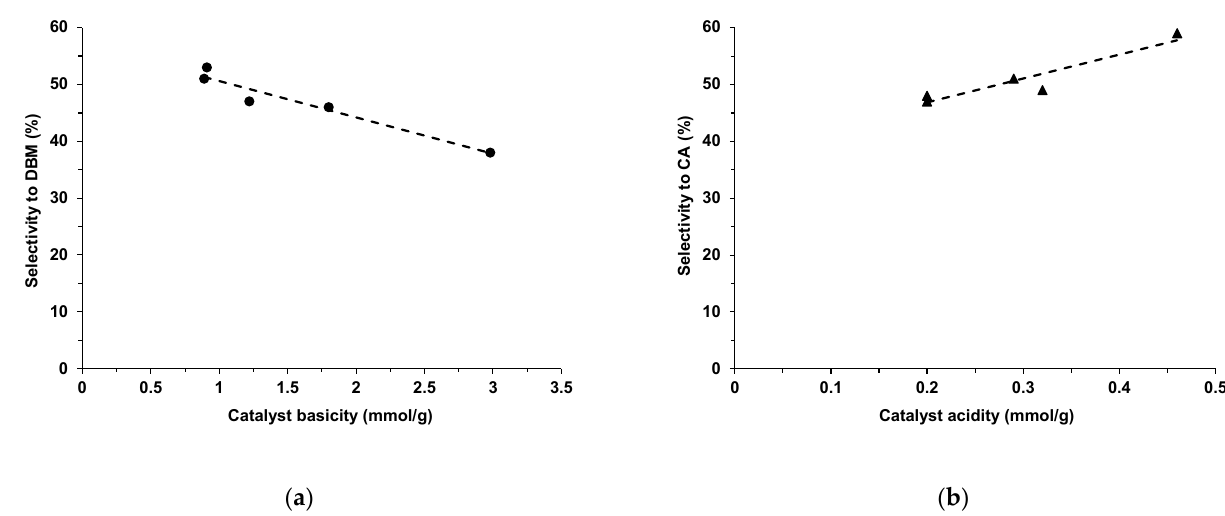
Figure 7. Selectivity to DBM after 24 h reaction time vs. catalyst basicity ( a ) and selectivity to CA after 24 h reaction time vs. catalyst acidity ( b ) for the HT3Ce-xGO composites in the Knoevenagel condensation of benzaldehyde with diethylmalonate. The conversion values for the one-pot oxidation-Knoevenagel condensation cascade reaction and the yields to 2-benzoyl-3-phenylacrylonitrile (BPA) can be seen in Table 5 and